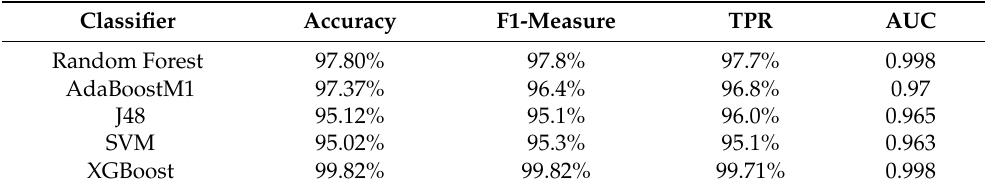
Table 4. Performance matrix of machine learning classifiers on system call